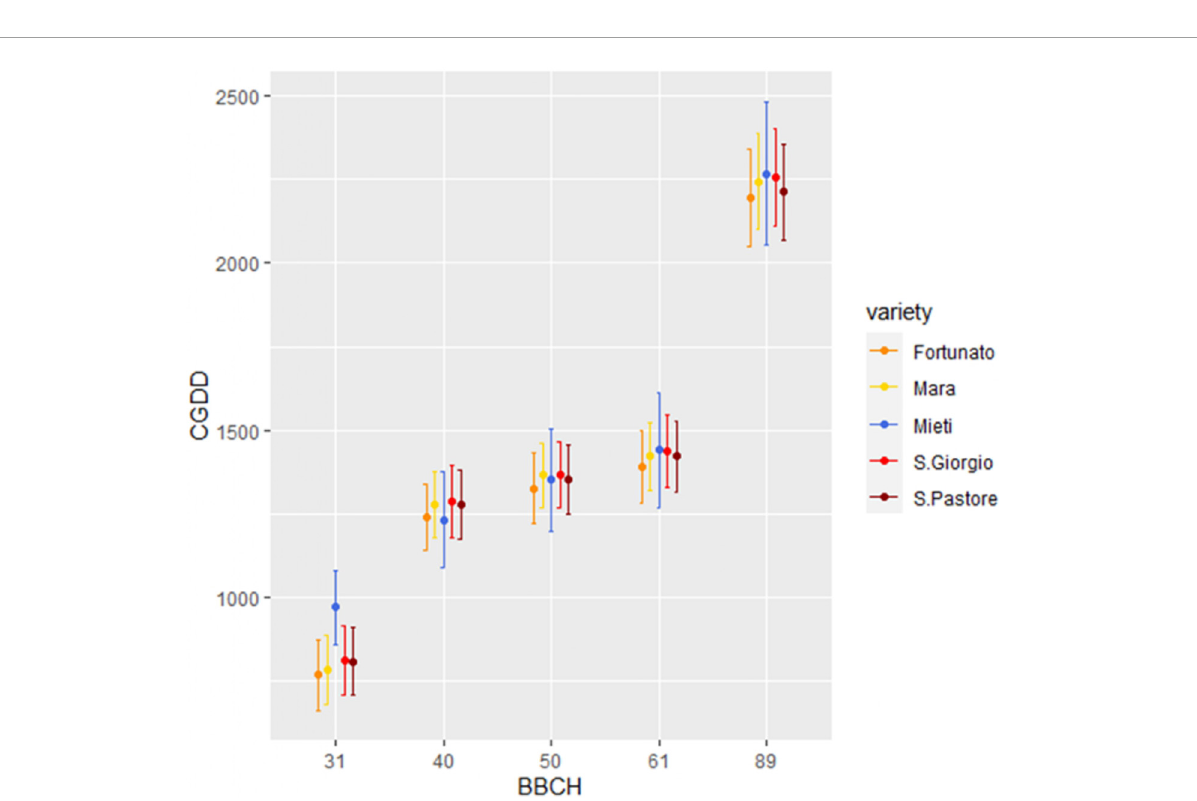
FIGURE5 Cumulative growing degree days (CGDDs) necessary to reach the selected BBCH stages, for each variety. Dots represent the mean of 15 agronomic seasons, and upper and lower bars represent one standard deviation. San Pastore, Mara, Fortunato, and San Giorgio belong to the past period, Mieti to the